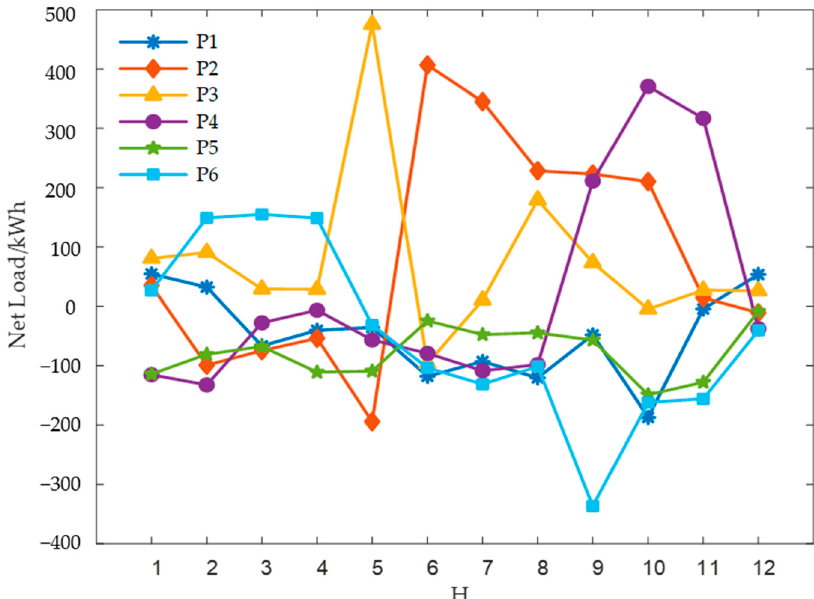
Figure 14. Net load of the prosumers.